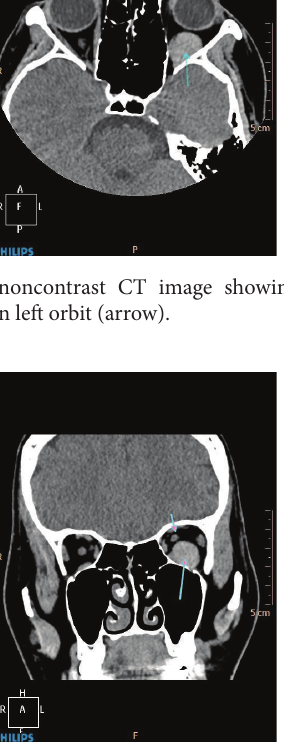
Figure 2: Coronal noncontrast CT image showing hyperdense haematoma (long arrow) and superomedially displaced left optic nerve (short arrow).